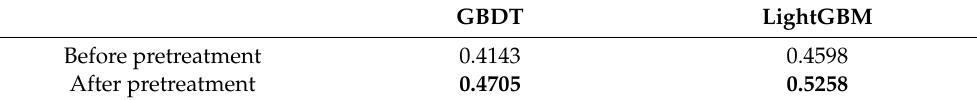
Table 7. The influence of the preprocessing scheme.